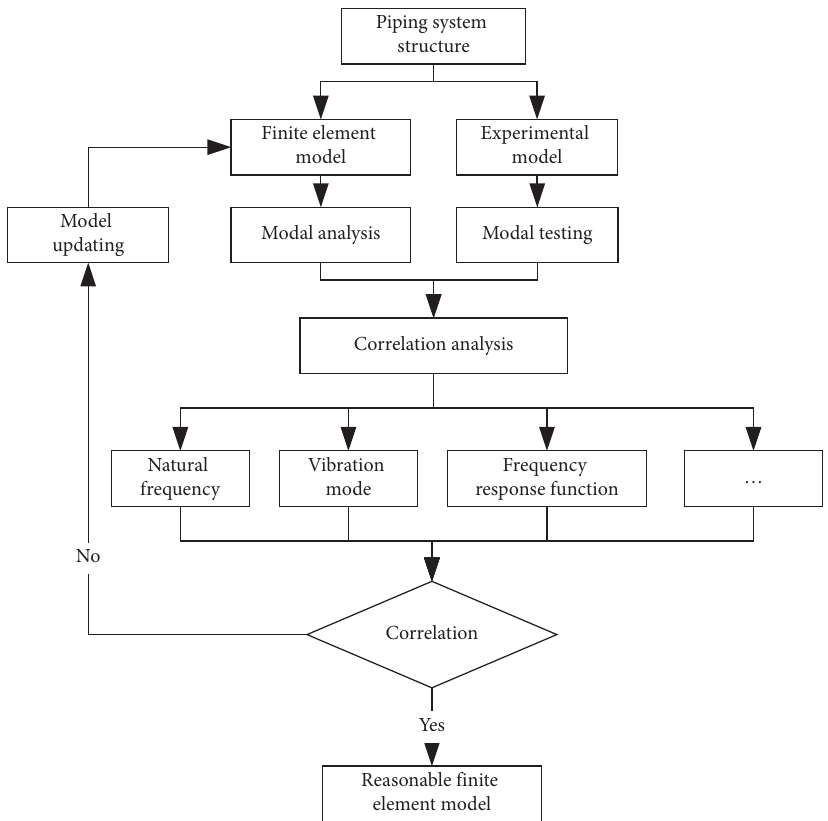
Figure 11: Finite element model revision